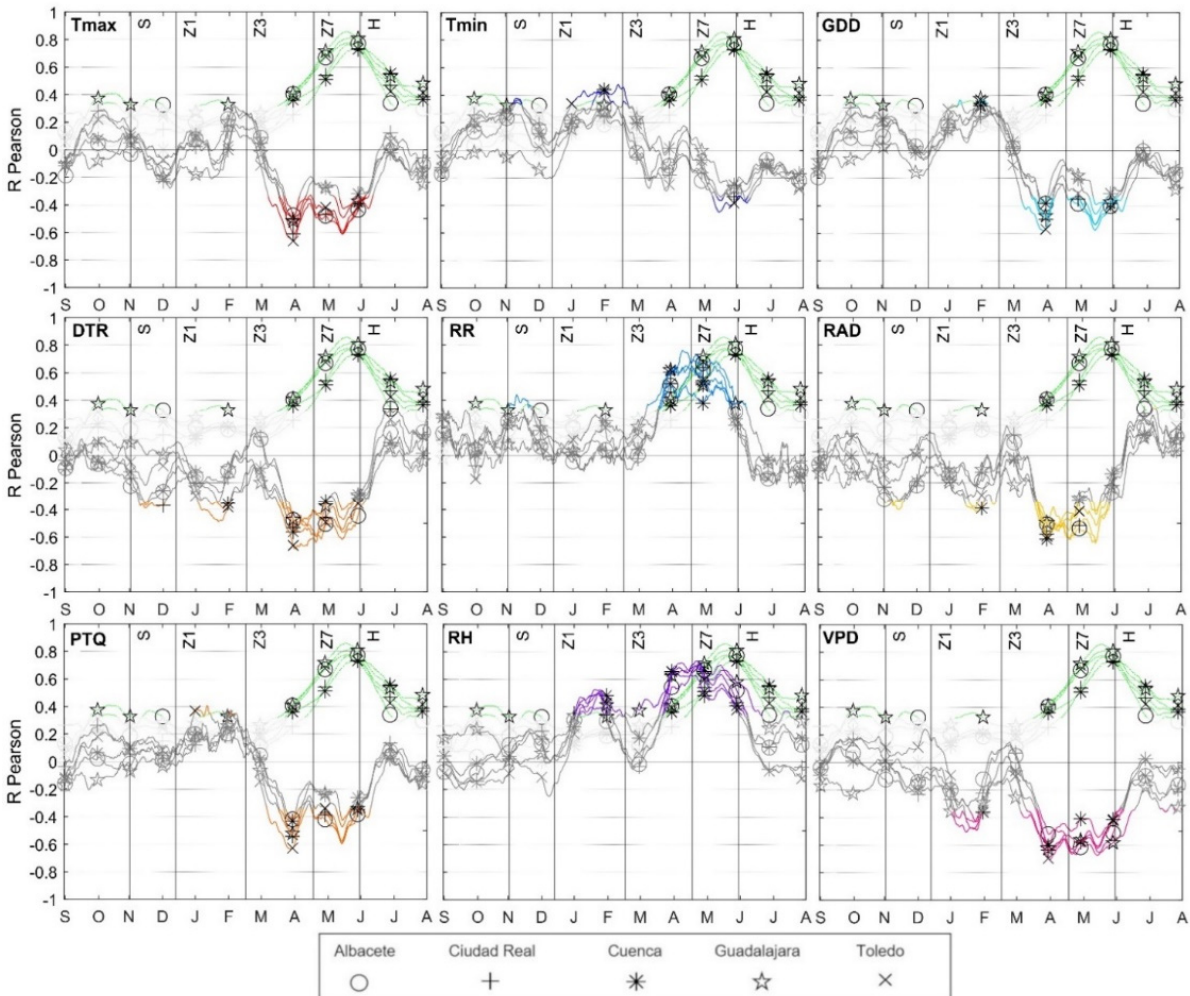
Figure 6. Daily correlations (line plots indicating the R coefficient values) and periods of significance (colored line segments) of the most relevant climatic variables with the annual yield of barley during the growing season in each province of CLM (see symbols). Vertical lines indicate phenological stages (Zi) of the Zadoks scale for barley in CLM. Periods of significant correlation of ERA5-Land soil moisture with annual barley yield (Figure 4(a3)) are shown in green and nonsignificant periods are in light gray for reference. Months are indicated on the primary x-axis and Zadok’s stages over the vertical lines from the secondary x-axis.